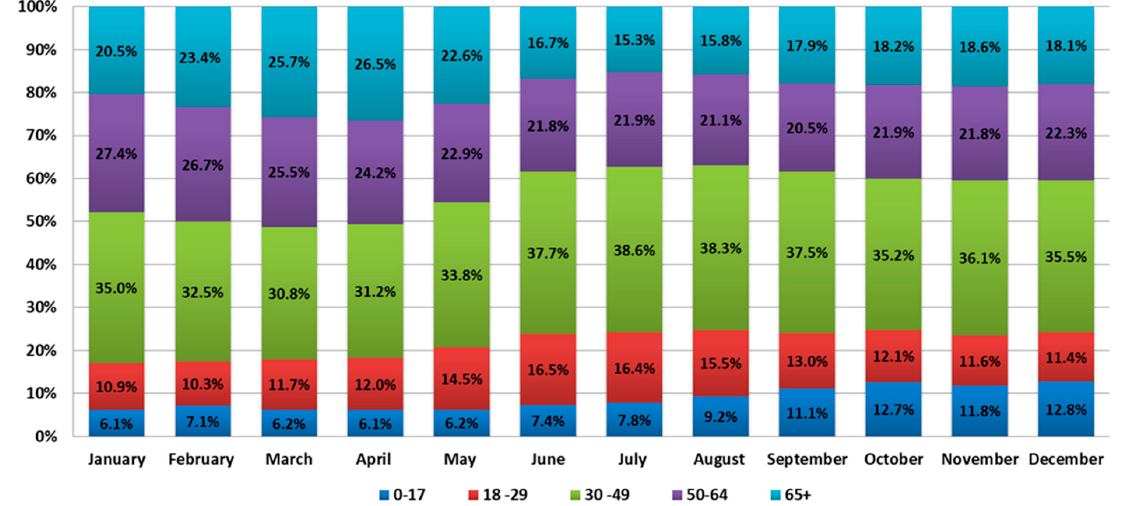
Figure 2. Changes in the demographic structure of COVID-19 incidence in 2021. The proportion of children among new COVID-19 cases increased twofold in 2021. Figure based on Rospotrebnadzor data.